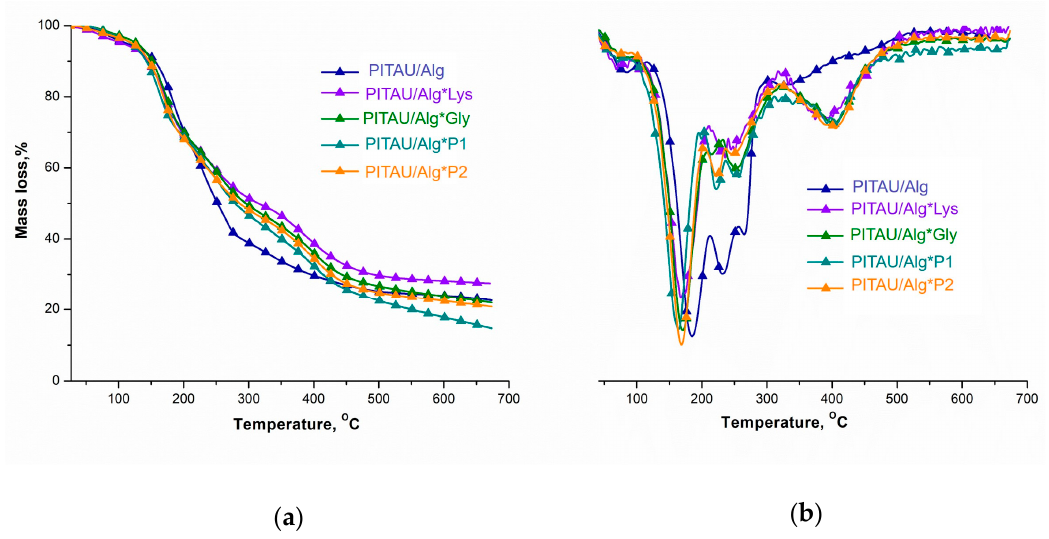
Figure 9. (a) TG and (b) DTG curves of the DN hydrogel and PITAU/Alg pre-gel. Figure 9. ( a ) TG and ( b ) DTG curves of the DN hydrogel and PITAU/Alg